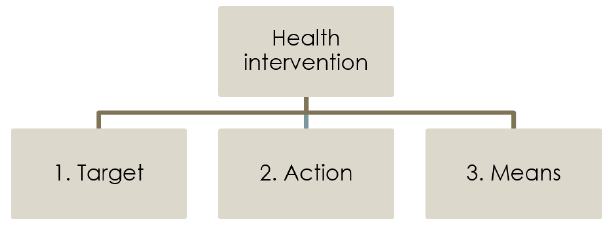
Figure 1. The three axes to describe a health intervention in ICHI.